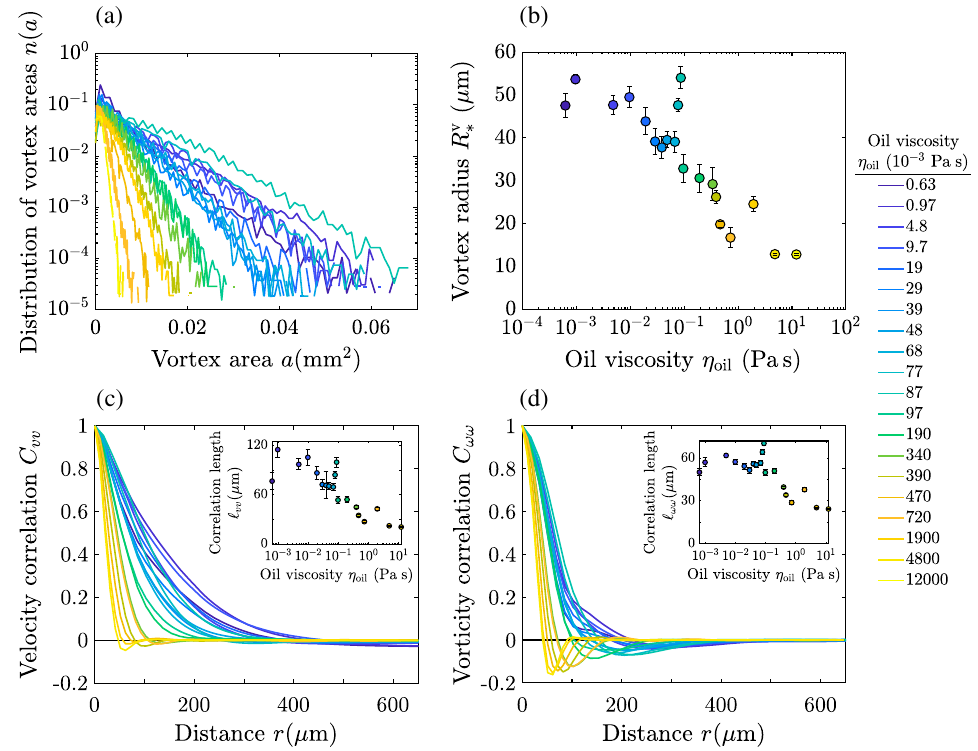
FIG. 4. Vortex size and correlation functions in active nematic turbulence. (a) Vortex area distributions in the active turbulence regime for 20 different oil viscosities. The distributions are obtained by measuring vortices in 500 frames. (b) Mean vortex radius obtained from the exponential tails of the vortex area distributions in (a) (see Appendix A). Error bars are standard errors of the mean. (c),(d) Spatial autocorrelation functions of the velocity (c) and vorticity (d) fields, for all 20 oil viscosities. The data are averaged over 500 frames. The insets show the corresponding correlation lengths, defined by the conditions C vv ð l vv Þ ¼ 0 . 5 and C ωω ð l ωω Þ ¼ 0 . 5 , respectively. Error bars are standard errors of the